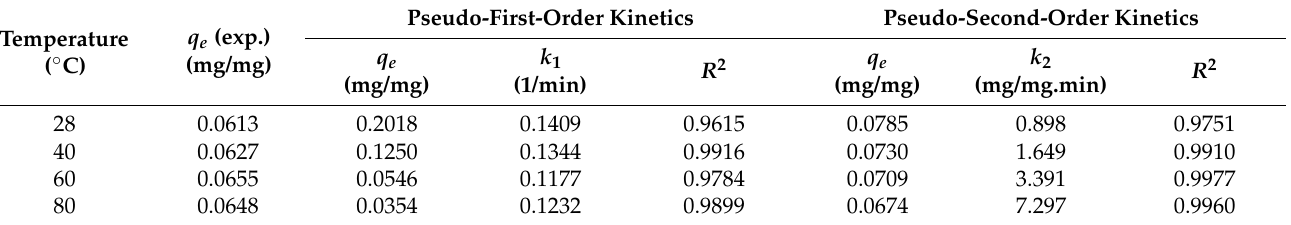
Table 3. Adsorption kinetics modeling for the removal of Cr(VI) from aqueous solution using CNCs as an